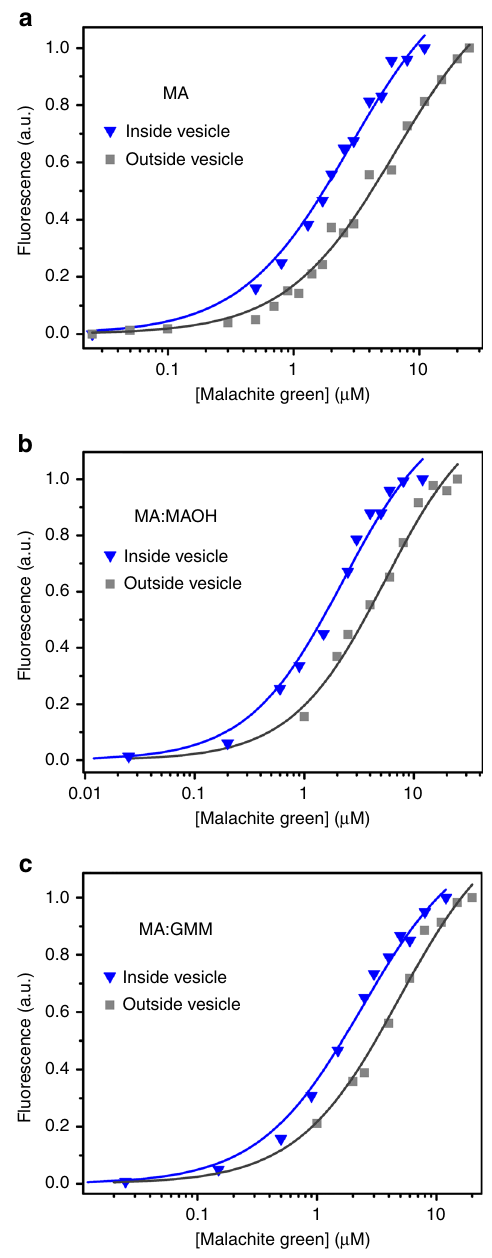
Fig. 2 MG aptamer af fi nity in fatty acid vesicles. a Encapsulation in MA vesicles (blue triangles) results in increased af fi nity compared to aptamer exposed to empty vesicles (gray squares). Representative binding curves are shown. Curve fi ts to the Hill equation are shown as lines (blue: K D = 2.5 ± 0.2 μ M; gray: K D = 6.8 ± 1.4 μ M). Encapsulation in b MA:MAOH (blue triangles: K D = 2.1 ± 0.2 μ M; gray square: K D = 5.2 ± 0.1 μ M) or c MA:GMM (blue triangles: K D = 2.4 ± 0.1 μ M; gray square: K D = 5.1 ± 0.1 μ M) vesicles shows a similar effect. Values given are mean ± standard